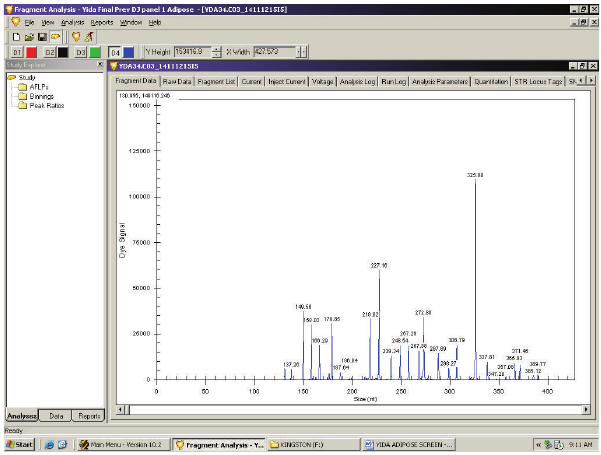
Figure 1: Representative electropherogram following gene expres- sion analysis on GenomeLab GeXP genetic analysis system (Beck- man Coulter Inc., USA). The genes and their expected sizes were Irs2-137; Slc2a2-149; Kcnj11-158; Insr-166; Glut4-178; Irs1-188; Gck- 197; Mapk8-218; Pklr-227; Prkcd-239; B2m-248; Hprt1-257; Mapk1- 268; Socs1-272; Rpl13a-287; Prkcz-298; Ikbkb-306; Kan(r)-325; Mtor-337; Pdx1-348; Pik3cd-357; Actb-365; Pik3r1-372; Pik3ca-385;